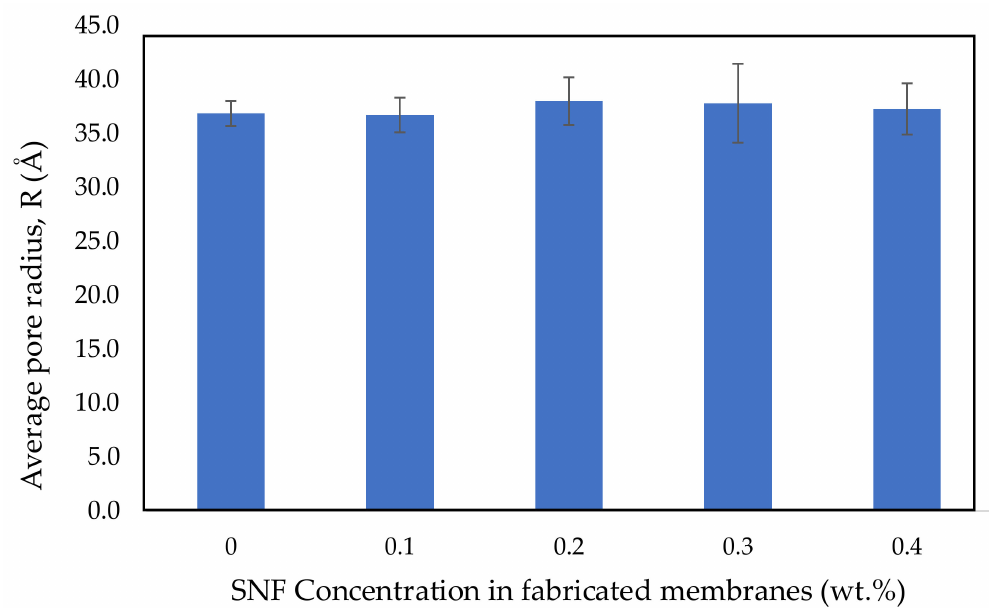
Figure 8. Effect of SNF concentration on the membrane average pore